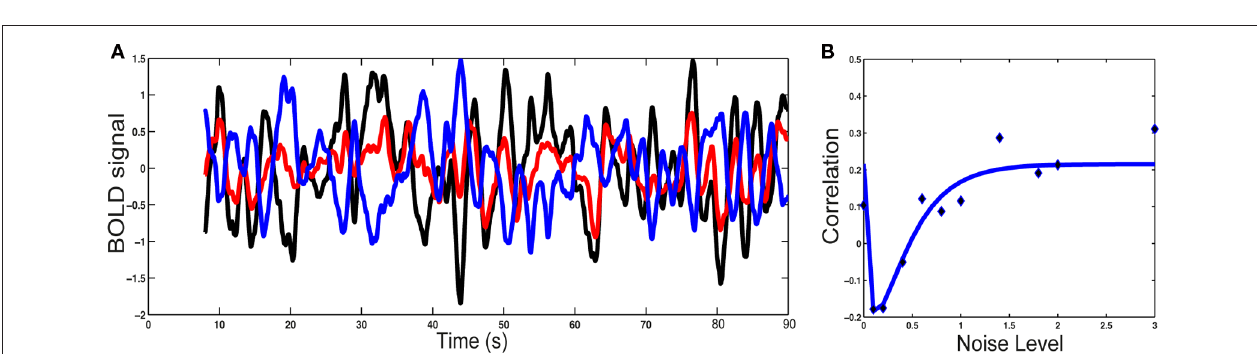
noise level: simulations (points) and non-linear least-squared fitting (curve). Note the stochastic resonance effect: there is an optimal noise level for which both communities are maximally anticorrelated. Figure adapted from Deco et al.